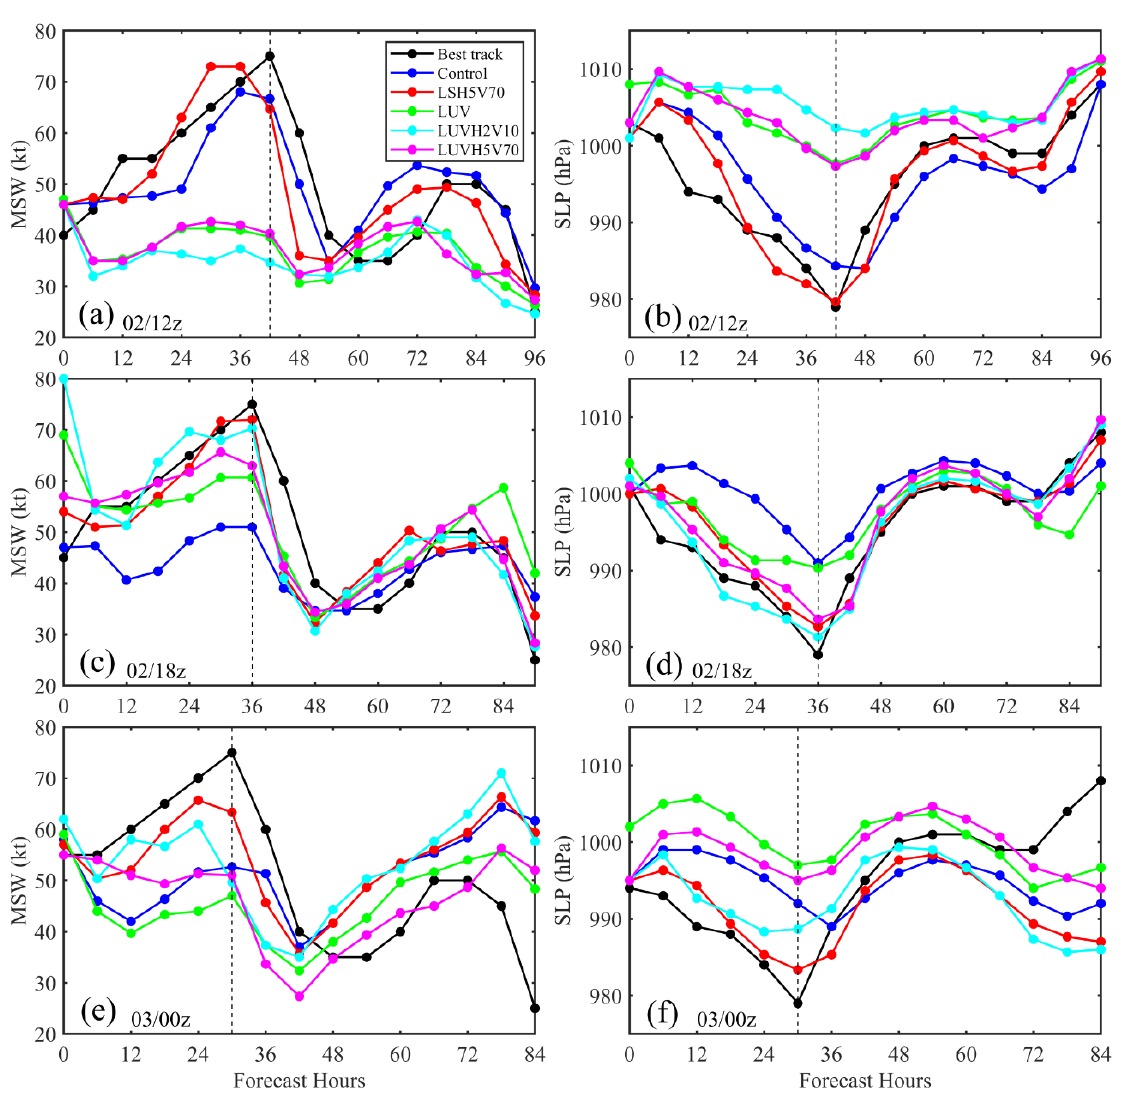
Figure 4. Comparison of the forecast ( a , c , e ) MSW and ( b , d , f ) SLP for Hurricane Earl for different DWL wind speed thinning experiments against Control and best track at ( a , b ) 12 UTC, ( c , d ) 18 UTC 2, and ( e , f ) 00 UTC 3 August 2016.